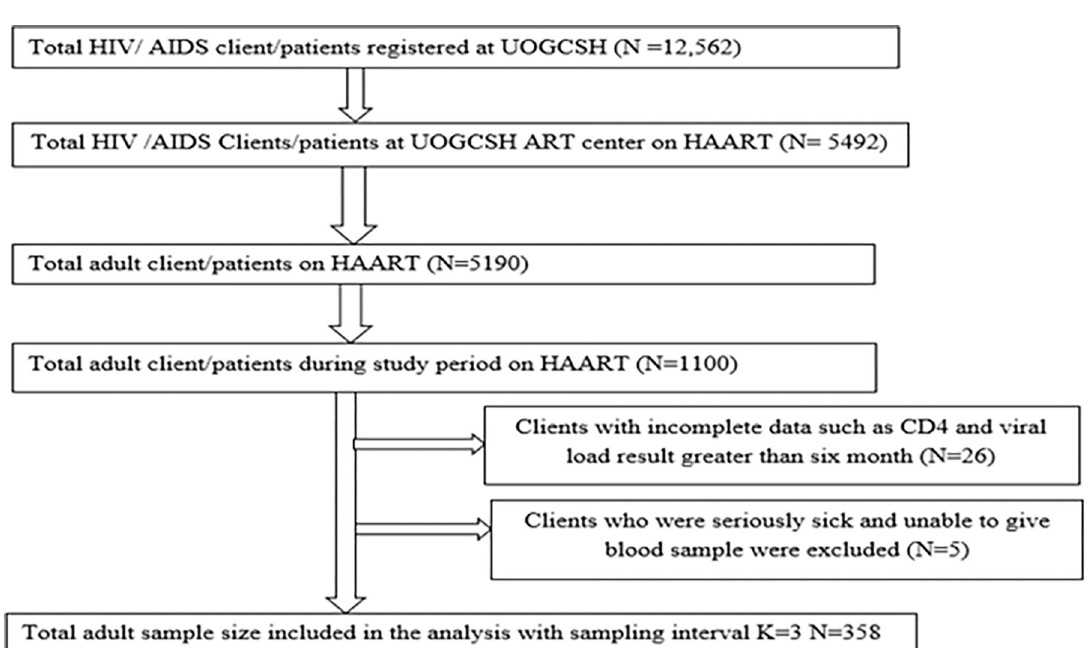
Fig 1. Schematic representation of the sampling procedure of HIV positive adults on HAART at University of Gondar comprehensive specialized hospital from March to April